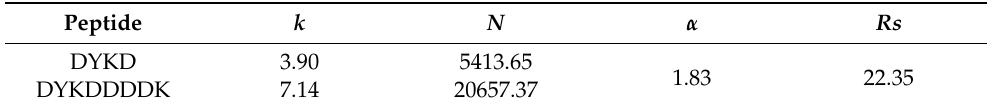
Table 2. Chromatographic parameters calculated from the standard solutions of DYKDDD and DYKDDDDDDDDDDK peptides (20 mg · L − 1 ).